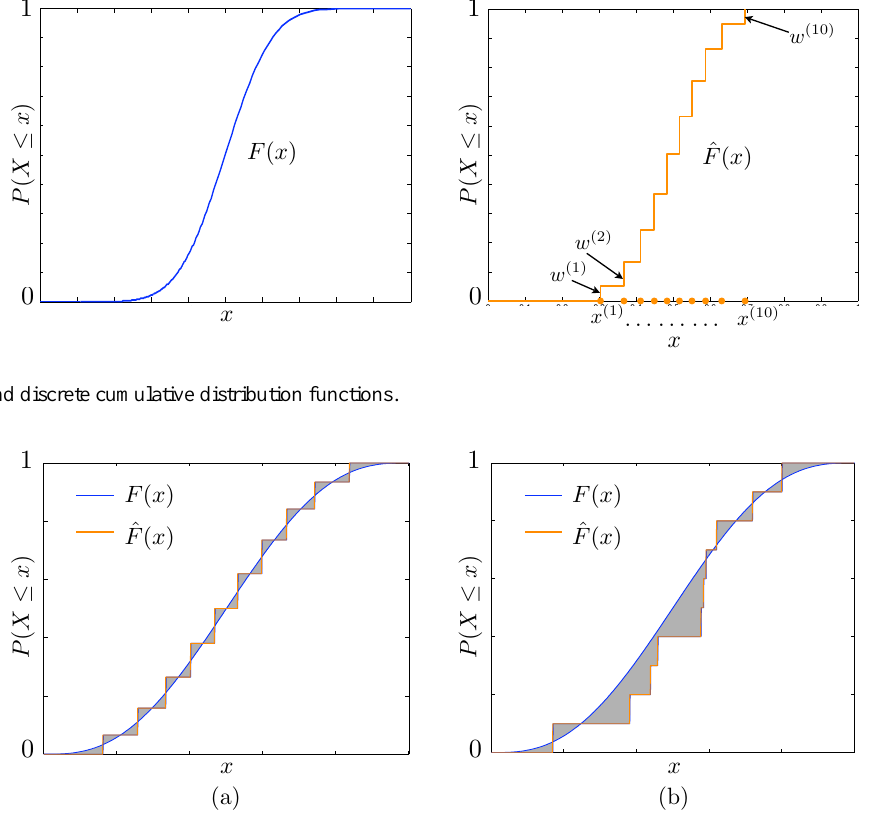
Fig. 3. The distance between f and ˆ f is defined as the shaded region area in the graphs. Optimal discrete distributions look like the one in graph (a) , while graph (b) represents a sub-optimal discrete